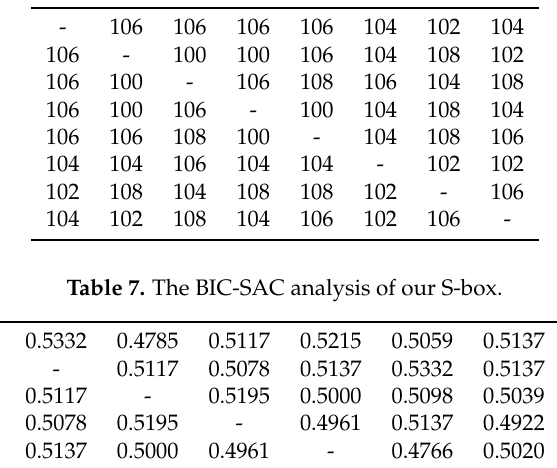
Table 6. The Bit Independence Criterion (BIC)-nonlinearity analysis of our S-box.